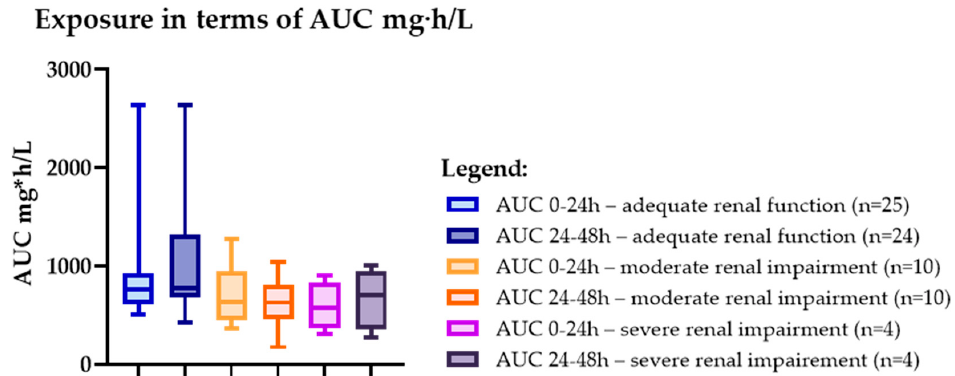
Figure 3. Exposure to ceftazidime in terms of AUC (mg · h/L) for the first 24 h of treatment (AUC 0–24 ) and the second 24 h of treatment (AUC 24–48 ) for different renal function groups. AUCs >1500 mg · h/L in the adequate renal function group were patients with eGFRs ranging between 51 and 77 mL/min/1.73 m 2.